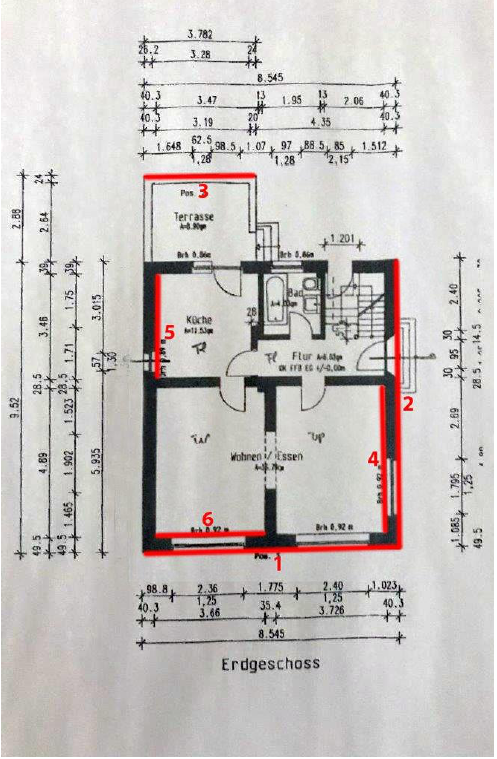
Figure 13. Floor plan with reference data and measured (red) wall parts. Table 3. Selected distances measured in the IPS point cloud and 3D vector model compared with the references shown in Figure